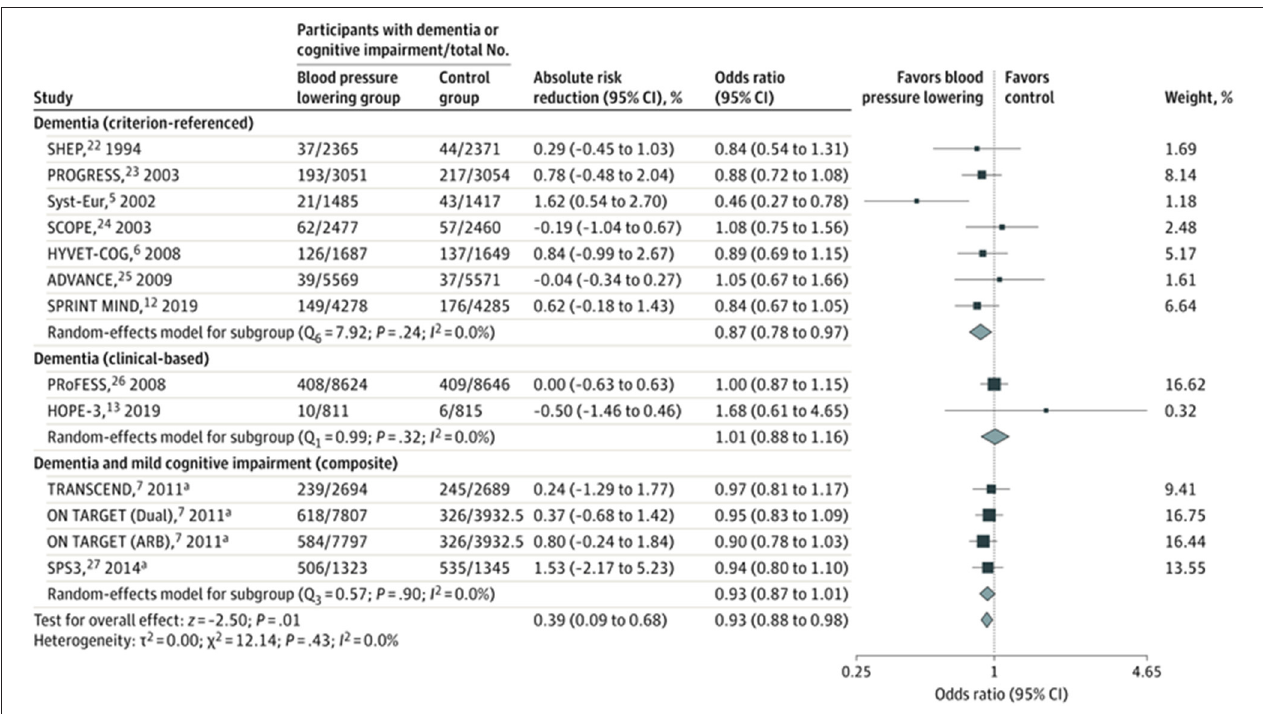
FIGURE 2 | Meta-analysis of blood pressure lowering randomized controlled trials. The squares and bars represent the mean values and 95% CIs of the effect sizes and the area of the squares reflects the weight of the studies. Diamonds represent the combined effects and the vertical dotted line represents the line of no association. a Composite of dementia and cognitive impairment [Hughes et al. ( 6), reproduced with